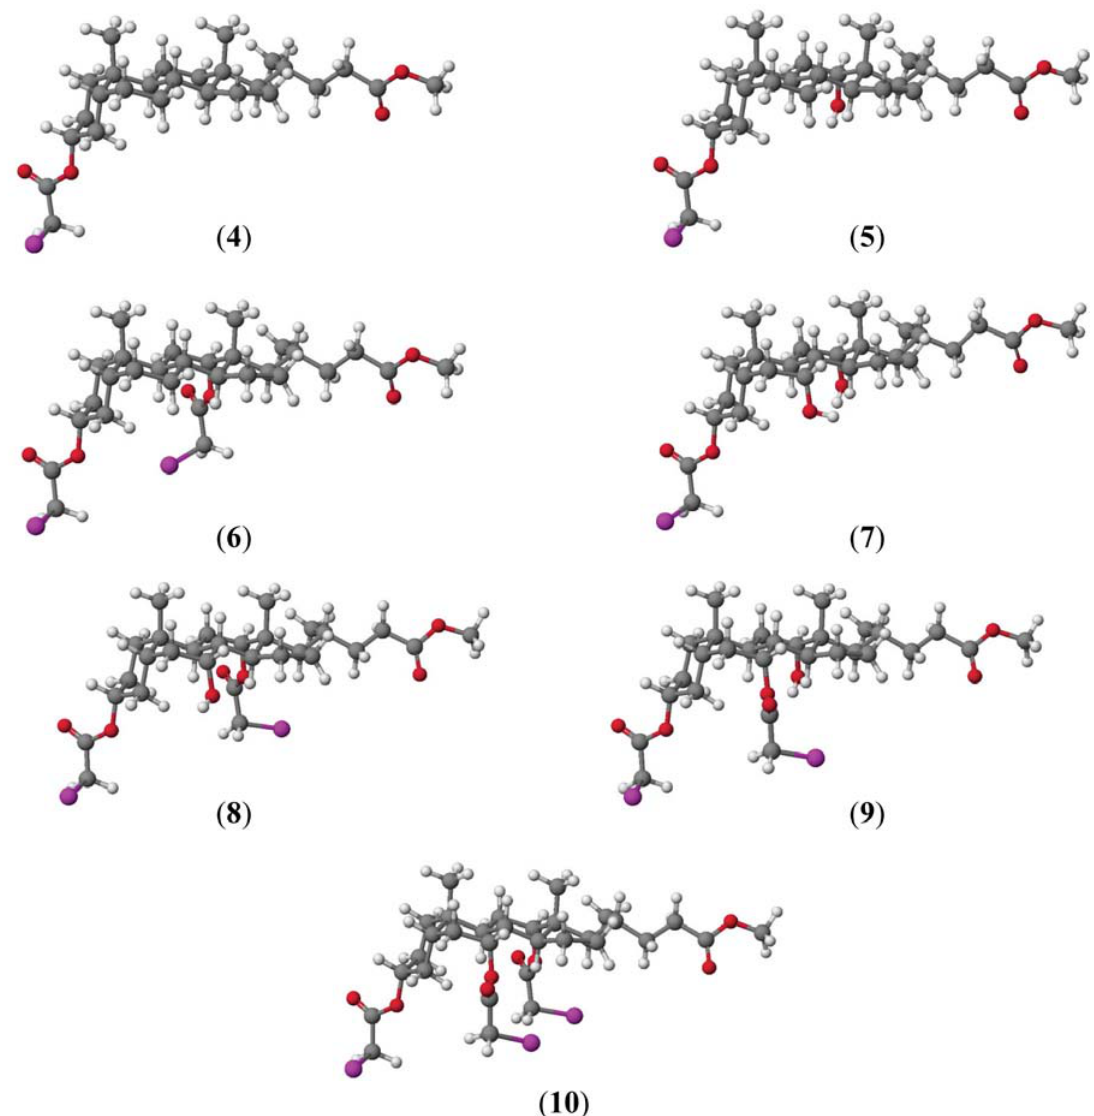
Figure 1. Molecular models of compounds 4 – 10 calculated by PM5